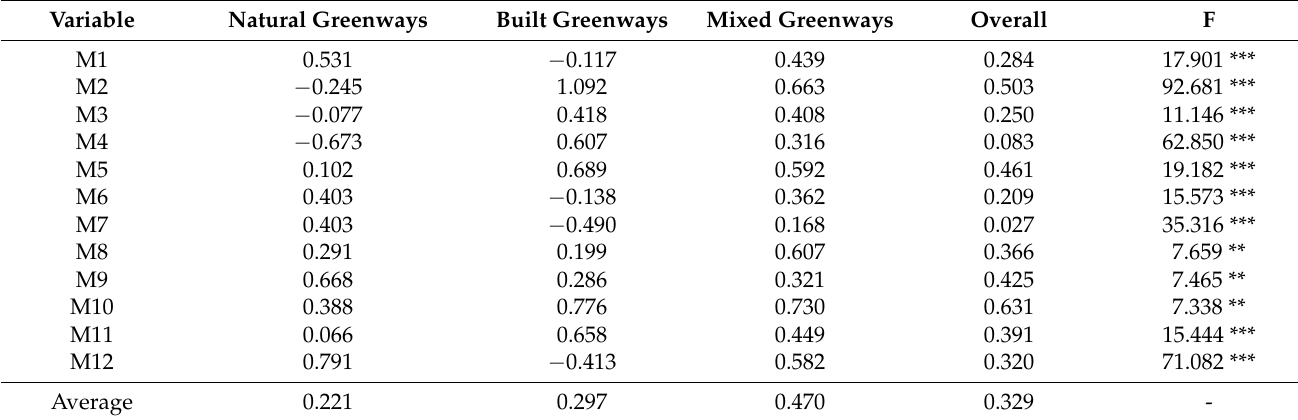
Table 3. Semantic differential factor scores of residents’ perceptions of riverside greenways. Variable Natural